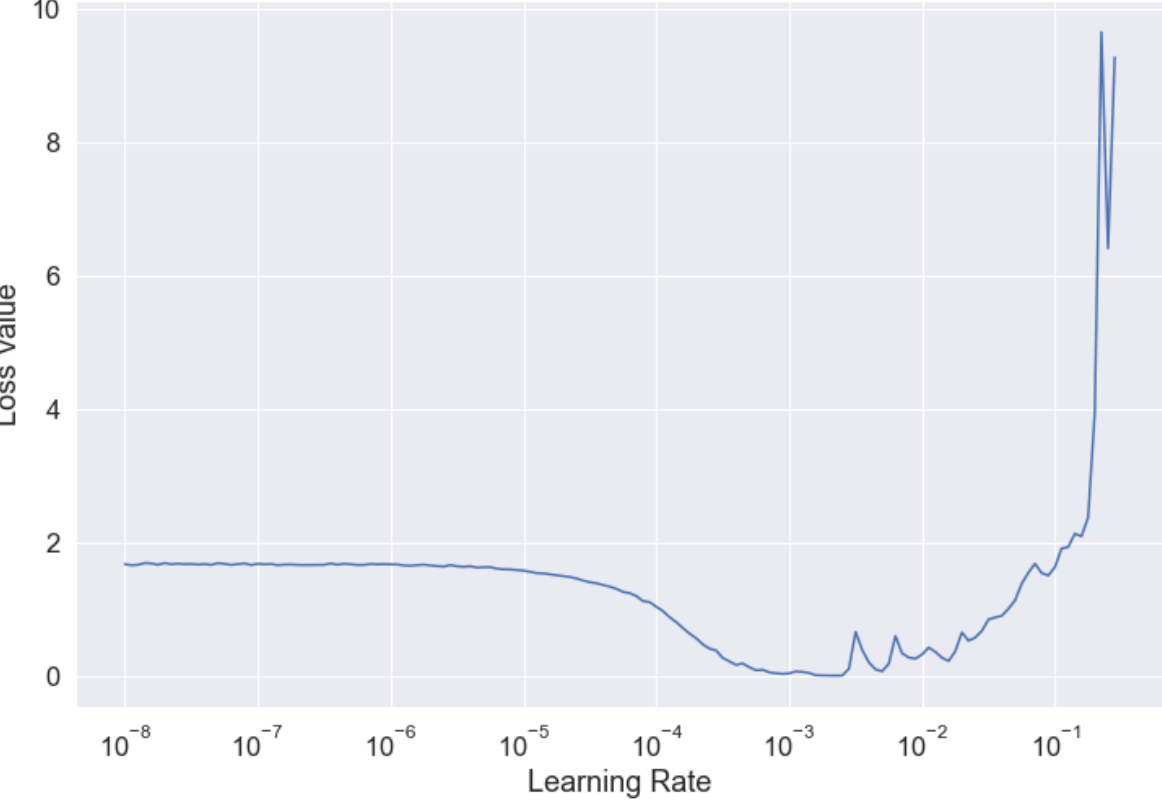
Figure 15. Exponential decay schedule for Experiment